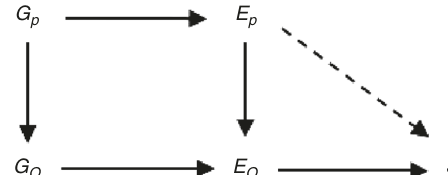
Fig. 2 Potential for bias due to dynastic effects. DAG showing how dynastic effects can introduce bias into an MR model. G p is parental genotype, E p parental educational attainment, G is offspring genotype, E O offspring O educational attainment and S O offspring smoking. The dashed line represents the relationship required for dynastic effects to introduce bias in an MR study. DAG directed